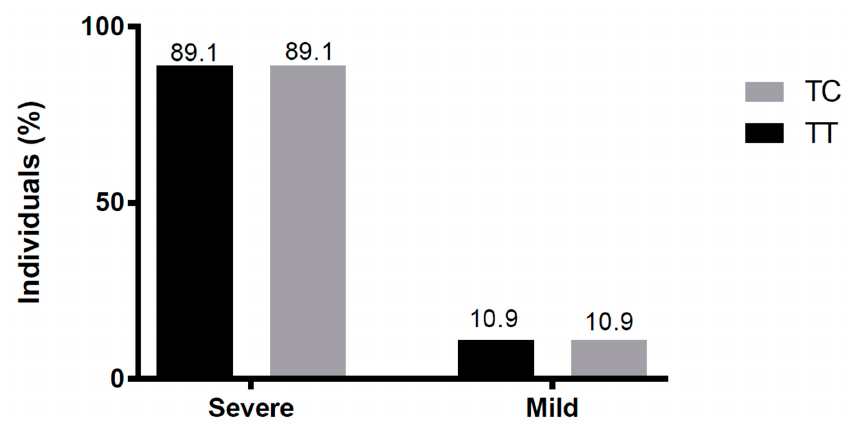
Figure 3. Genotype distribution among subjects with severe or mild diseases. Severe patients comprised four each with the TT or four CT genotype; TT and CT genotypes were present in 33 subjects with a mild